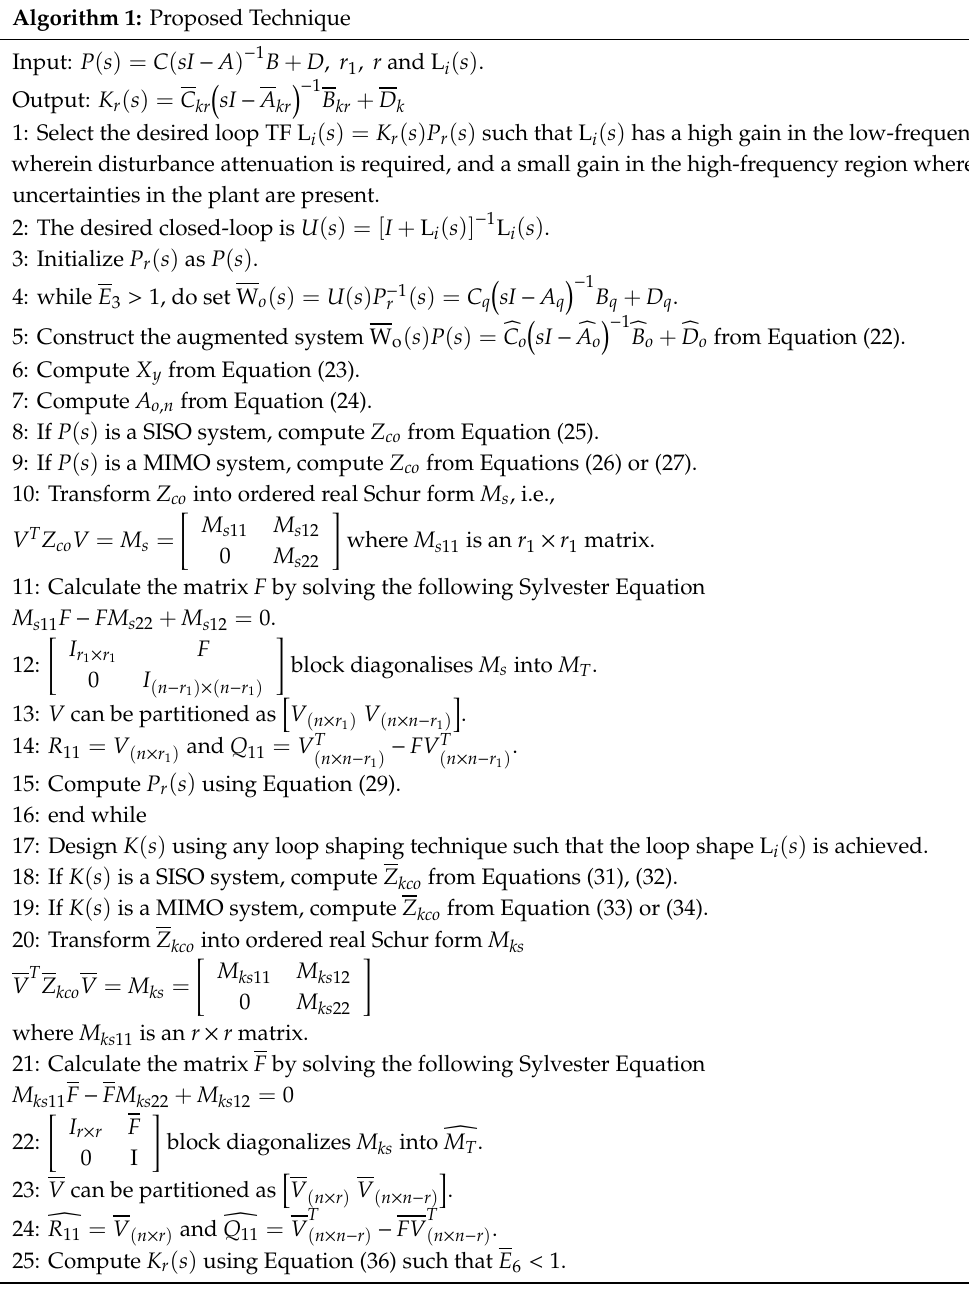
Algorithm 1: Proposed